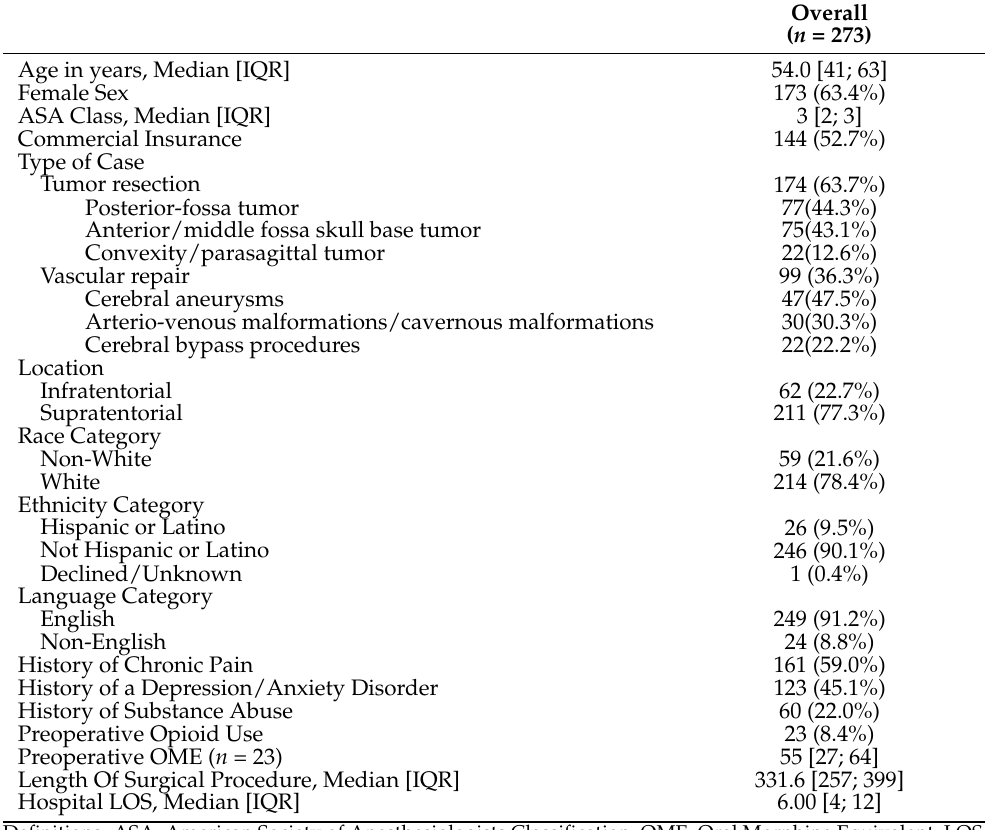
Table 1. Study Sample